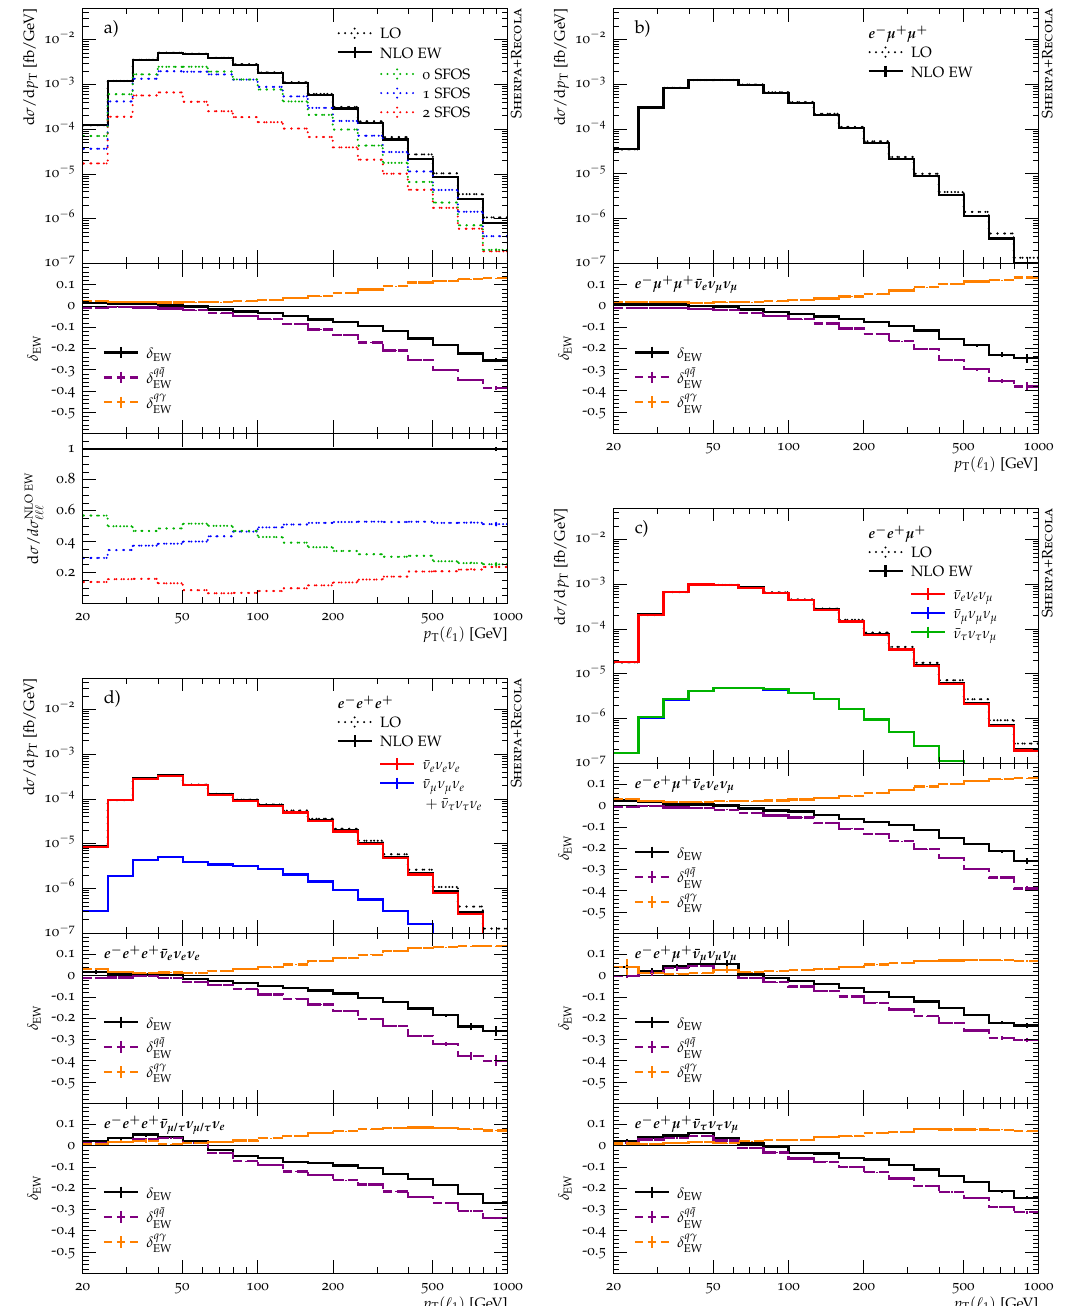
Figure 3 . Electroweak corrections to the leading lepton transverse momentum